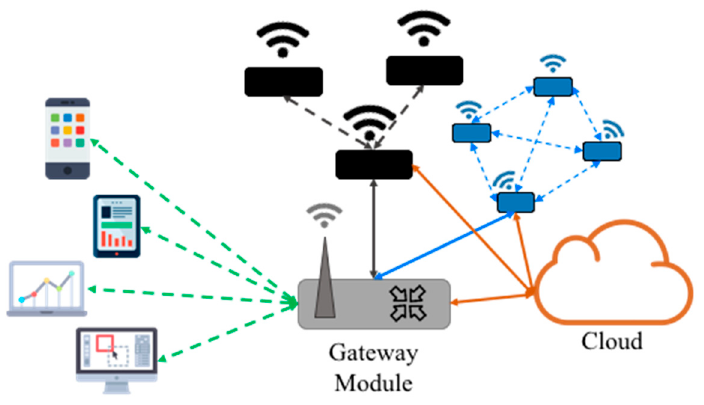
Figure 15. Gateway Figure 15. Gateway module.